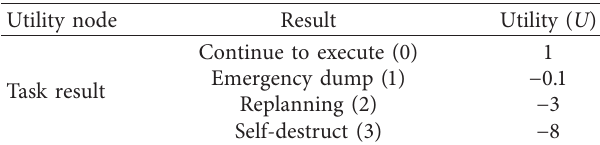
Table 7: Initial utility